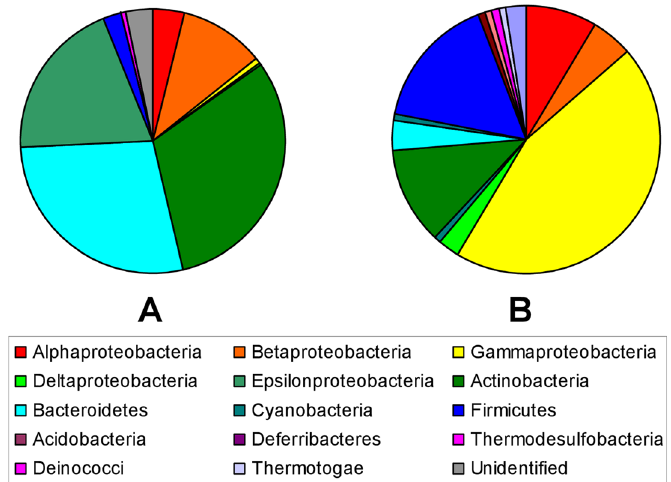
Figure 4. Microbial composition in the englacial ecosystem in Mount Pond Glacier. Pie charts represent relative abundances of major taxa of bacteria in the englacial ecosystem in Mount Pond Glacier, based on ( A ) 16S rRNA gene sequencing and ( B ) proteomics data.